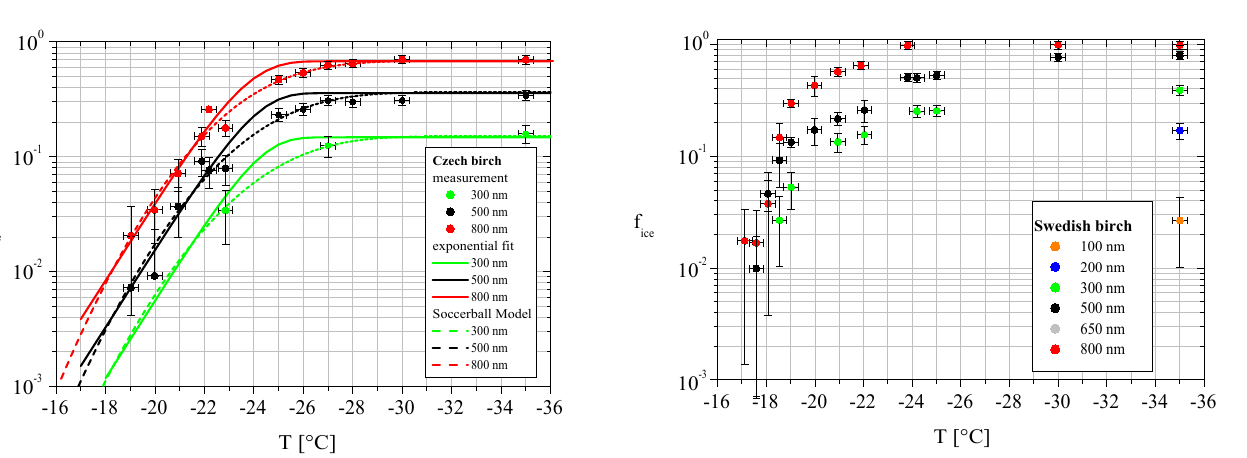
Fig. 6. Ice fraction f ice as a function of temperature T for 100, 200, 300, 500, 650 and 800nm Swedish birch pollen washing water particles.